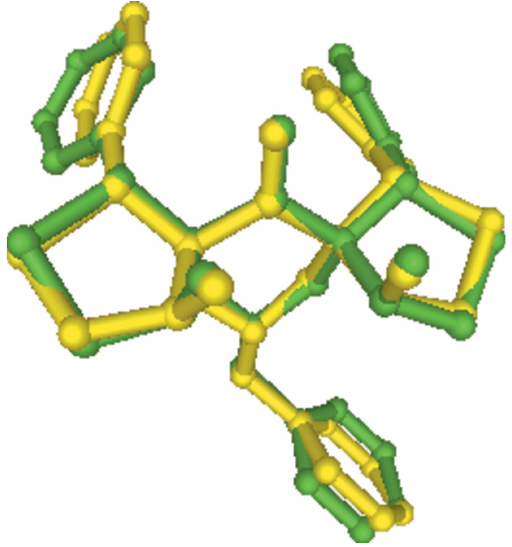
Figure 2 An overlay of similar atoms of the title molecule (green) and the related compound 2 (yellow), excluding H atoms, indicating their nearly identical conformations.